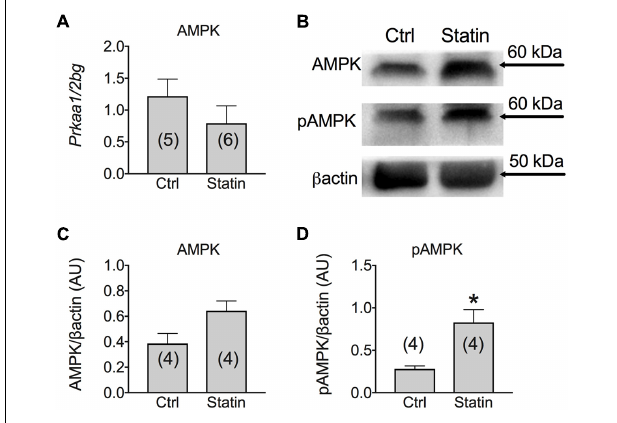
FIGURE 6 | (A) Real-time PCR analysis of mRNA expression level of AMP Kinase (AMPK) gene involved in muscle energetic metabolism in VL muscle biopsies of patients in therapy with statin showing sign of myopathy. Histograms show quantification of transcript levels for AMPK normalized by the beta-2 microglobulin gene. In each graph, the bars represent the mean values ± SEM in myopathic subjects (Statin) compared with those of untreated subjects (Ctrl) from the number of subjects indicated in brackets. (B) Representative Western blot showing the expression level of total AMPK protein and its phosphorylated form in muscle tissues. The blots were reacted with specific antibodies. β -actin was used to normalize the blot. Histograms show quantification of relative protein levels of total AMPK (C) and pAMPK (D) obtained by densitometric analysis of each protein normalized with β -actin, as reference standard, and represented as AU. Each bar represents the mean ± SEM from the number of muscle biopsies as indicated. ∗ Significantly different with respect to the own control ( P < 0.05) by Student’s t -test.